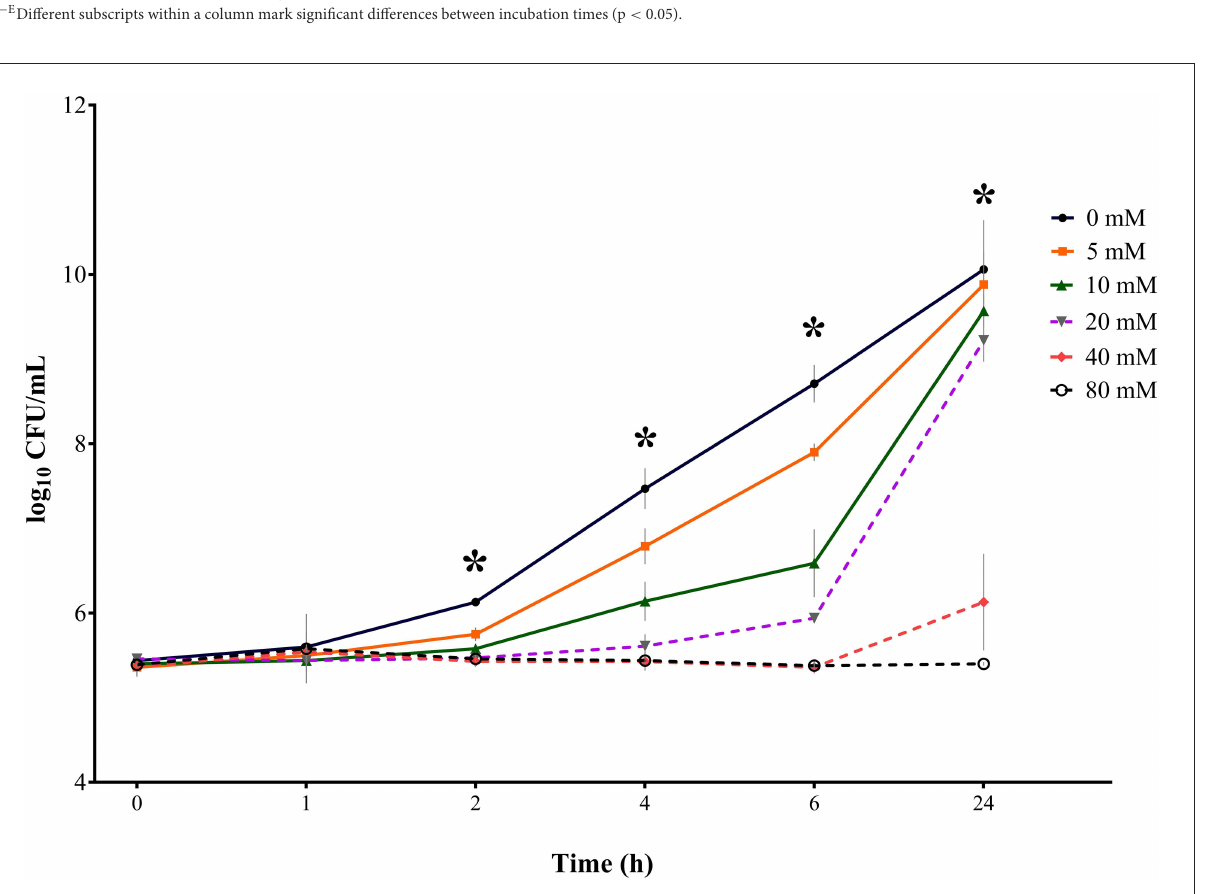
FIGURE3 Bacterial growth curves (log 10 CFU/mL) for S . Typhimurium DSM 19587 for three consecutive trials ( n = 3) for sodium butyrate (SB) concentrations 0, 5, 10, 20, 40, and 80mM and incubation times 0, 1, 2, 4, 6, and 24h; * indicates significant difference between concentrations ( p <